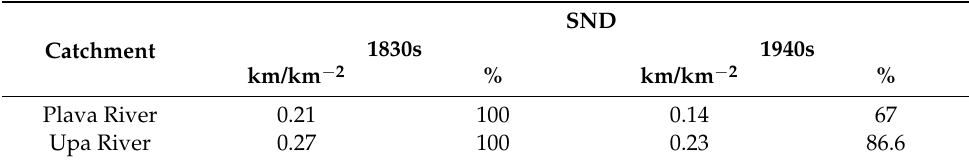
Table 2. Changes in SNDs of Plava and Upa River basins (Adapted with permission from Ref. [68]. 2006,